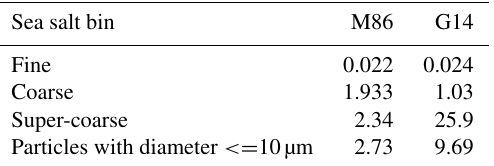
Table 5. Global emissions in 2014 (Pgyr − 1 ) of fine, coarse, and super-coarse sea salt as estimated by the M86 and G14 schemes. The total emissions of particles with a diameter under 10µm are also